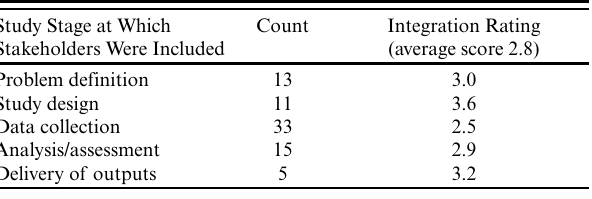
Table 4 . Comparison of integration ratings across the different phases at which stakeholders were involved in social-ecological studies. A study could involve stakeholders in more than one study phase. When comparing potential effects of involving stakeholders at different phases, i.e., problem definition, study design, data collection, analysis/assessment, and/or delivery of outputs, on overall integration scores, studies involving stakeholders in the design phase of a study were rated significantly higher for overall integration (t = 2.46, p < 0.02; other phases: p > 0.1; ordered logistic regression).